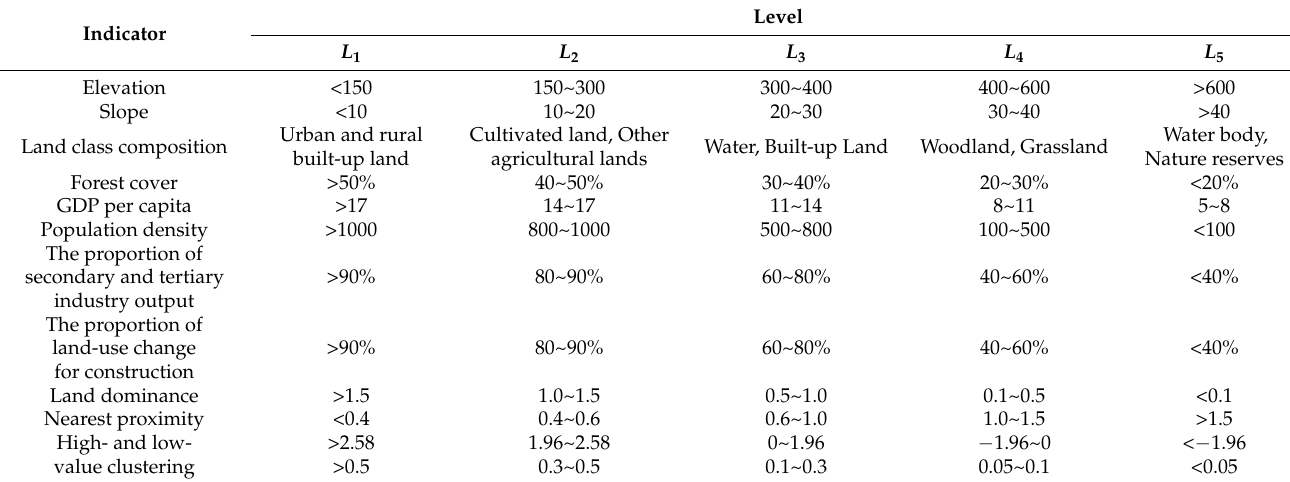
Table 3. Classification of land-use potential evaluation